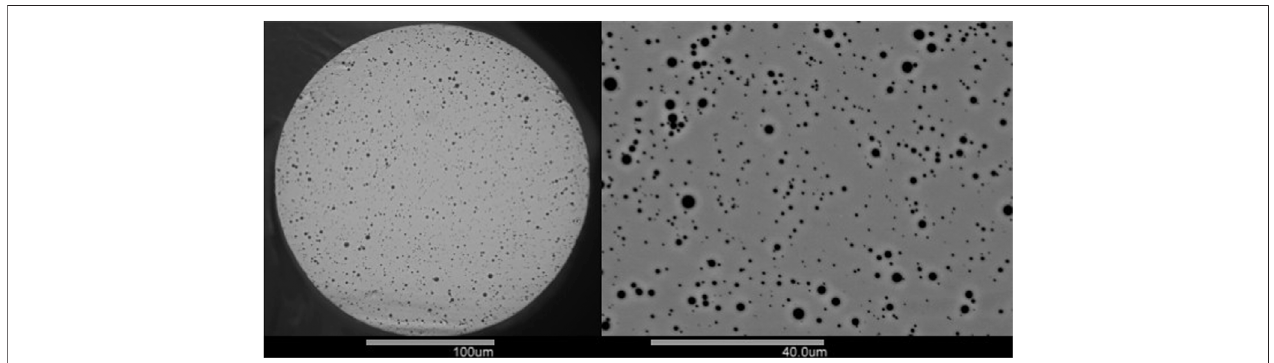
FIGURE 7 | The left panel shows that SEM image of the silica optical fi ber with random air-holes reported in Ref. [64] and drawn at Clemson University. The right panel shows a zoomed-in SEM image of the same fi ber. Reprinted/Reproduced with permission from Optical Material Express, 2012 [64], and the Optical Society of